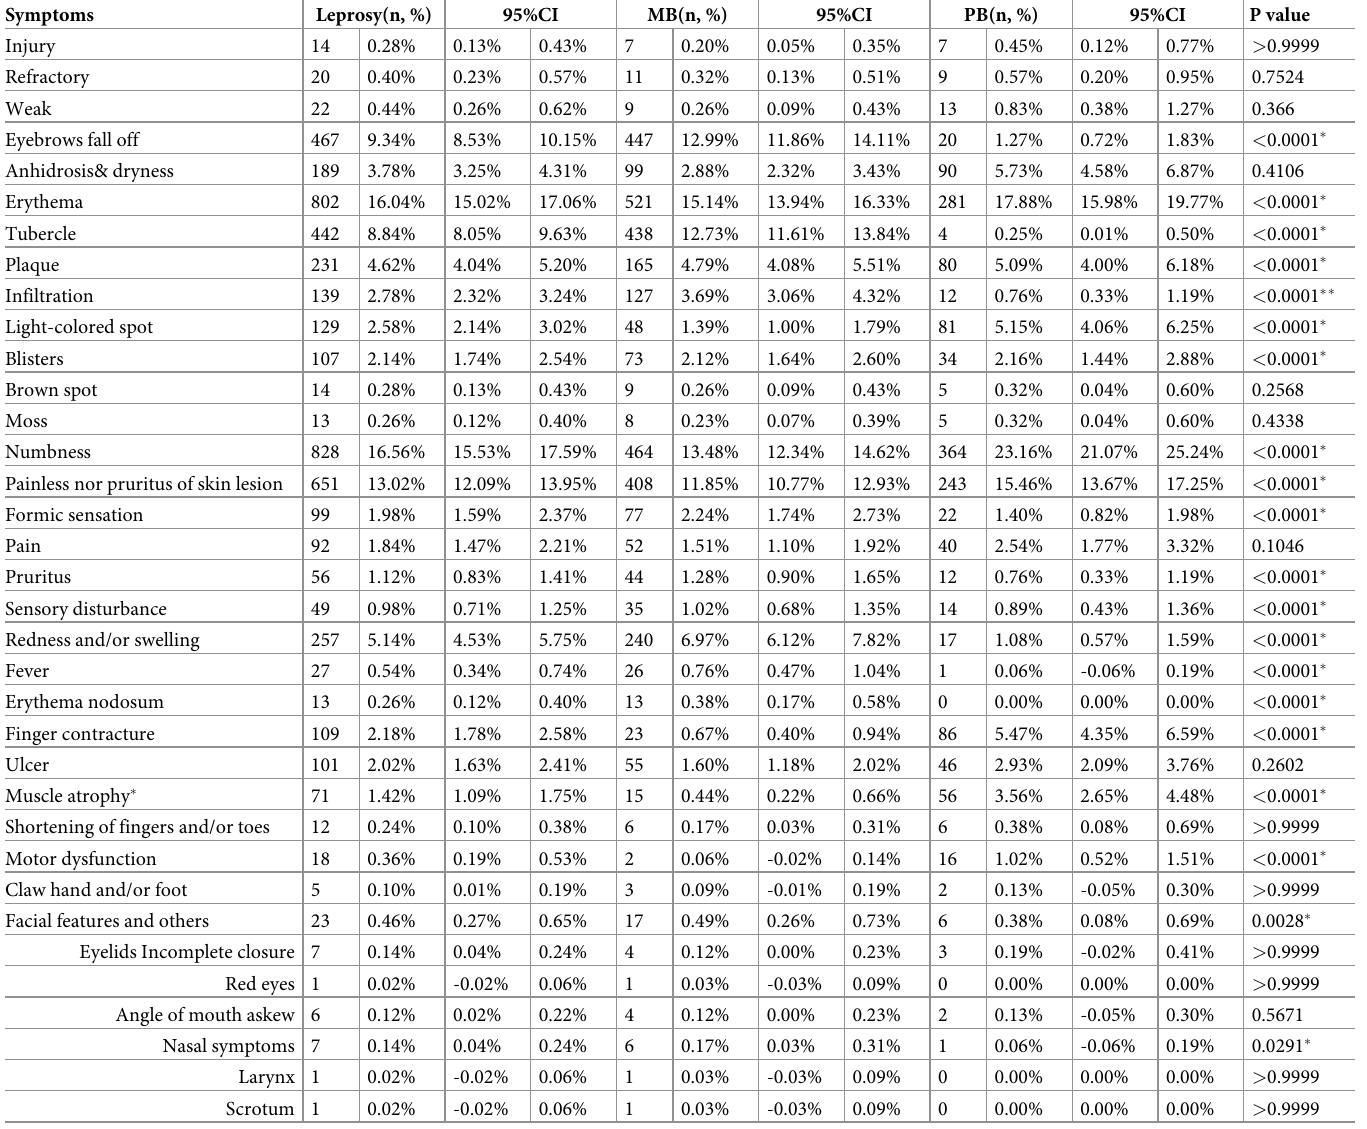
Table 4. Observed Proportions of Presenting Symptoms in MB and PB of Newly Detected Leprosy Cases in Yunnan, China